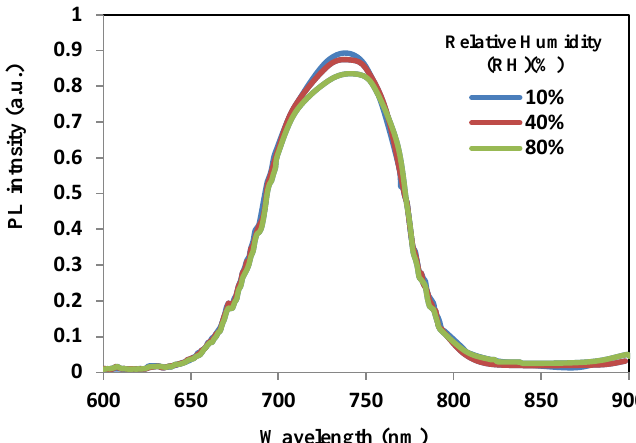
Fig. 6: PL spectra of PS prepare at J=20 mA/cm 2 at etching time was 15 min and the HF concentration was 15% with increasing RH levels.